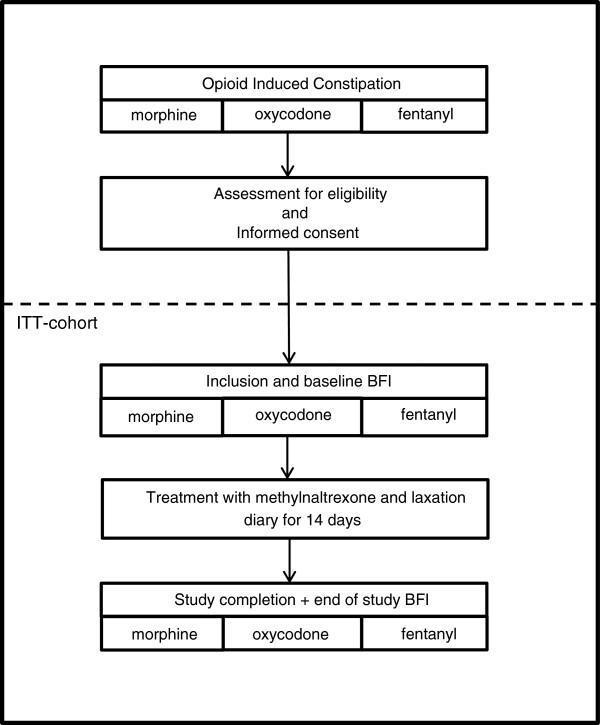
Study flow chart.